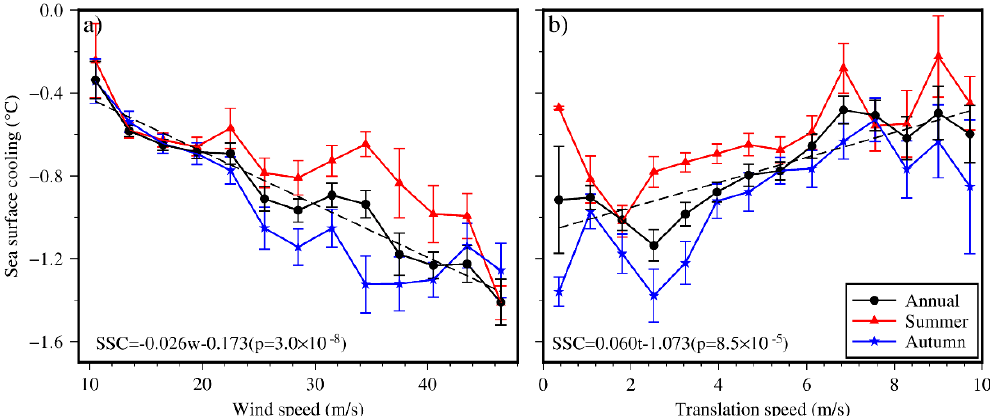
Figure 3. Dependence of typhoon-induced SSC on ( a ) wind speed and ( b ) translation speed of typhoons. Wind speeds between 10 m/s and 50 m/s and translation speeds between 0 m/s and 10 m/s were divided into 14 bins. Typhoons for the entire year (black), summer (red) and autumn (blue) are shown separately. The linear relationships for the entire year are illustrated and labeled for each panel with the p-value. The vertical bars represent the standard errors of sea surface temperature change ( Δ SST) within each bin.